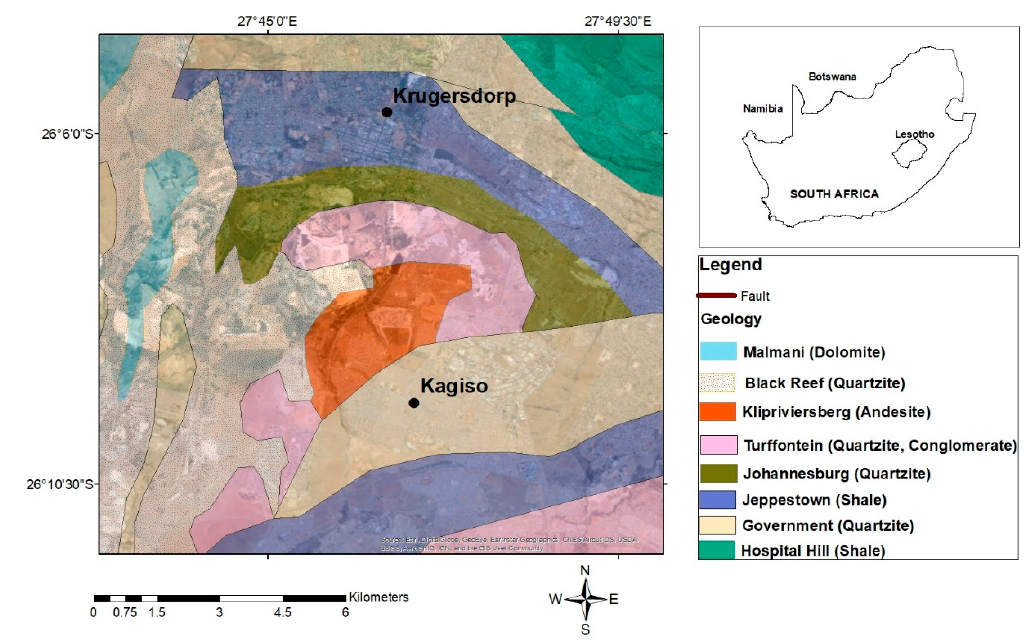
Figure 2. Local geology of the study area .